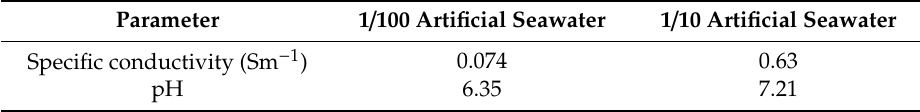
Table 1. Specific conductivity and pH of each test